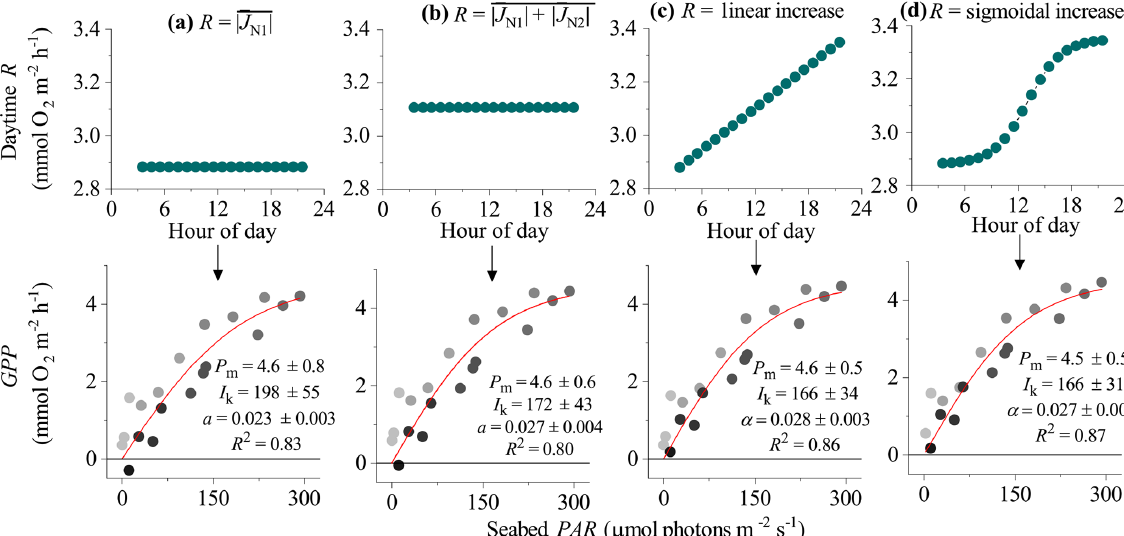
Figure 4. Different approaches for defining the R rate during the day (and therefore the hourly GPP) from eddy covariance fluxes show- ing hysteresis: (a) R is the average flux for the first night-time flux period ( | J N1 | ), (b) R is the average flux for both night-time periods ( | J N1 |+| J N2 | ), (c) R increases linearly from | J N1 | to | J N2 | , and (d) R increases from | J N1 | to | J N2 | following a sigmoidal curve. Bottom panels show corresponding light saturation curves and fitting parameters for the maximum rate of GPP ( P m , mmol O 2 m − 2 h − 1 ), the pho- toadaptation parameter I k (µmol PARm − 2 s − 1 ), the initial slope of the curve α , and the coefficient of determination ( R 2 ). Symbols in the bottom panels are colour-mapped by hour of day. Data modified from Attard et al. (2020).